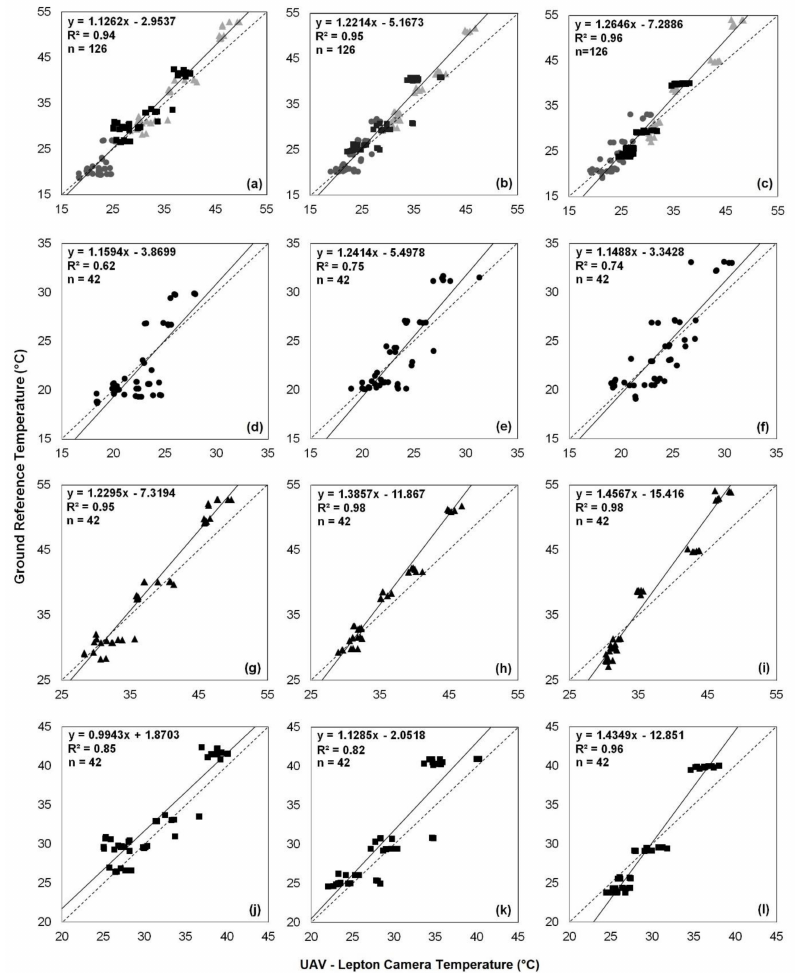
Figure 4. Linear regression models between temperature readings from the Lepton camera and ground reference temperature throughout the missions in di ff erent flight altitudes. Overall models for the 35- ( a ), 65- ( b ), and 100-m flight altitudes ( c ); individual models with for the 35- ( d , g , j ), 65- ( e , h , k ), and 100-m flight altitudes ( f , i , l ); symbols indicate datasets collected in the early morning ( • ), close to solar noon ( (cid:78) ), and at the end of the afternoon ( (cid:4) ). Dashed line = 1:1 line; solid line = linear regression line; p < 0.001 for all R 2